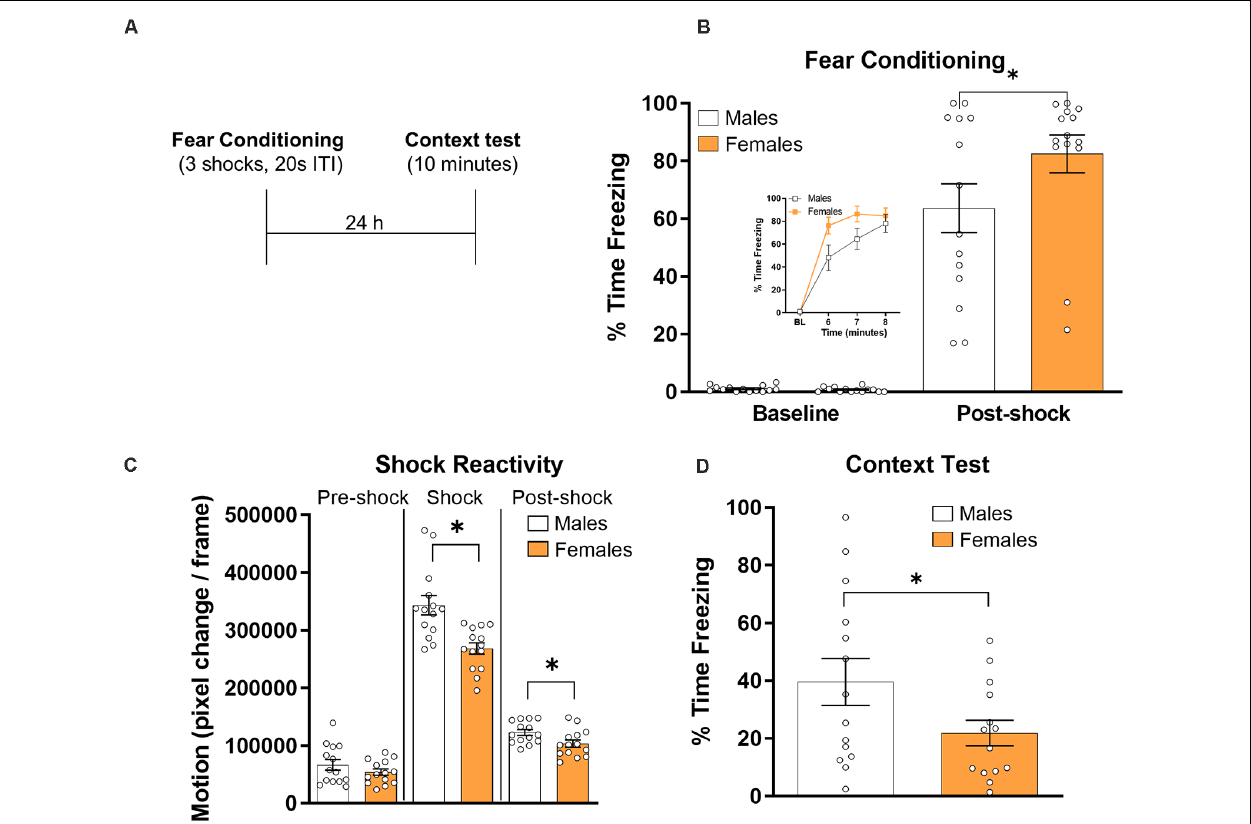
FIGURE 1 | Male ( N = 14) and female ( N = 14) were given contextual fear conditioning and freezing behavior was assessed during a 10 min test session the next day (panel A depicts the timeline of the experiment). (B) Freezing behavior during the baseline and post-shock periods during the fear conditioning session. The inset graph shows average baseline freezing and minute-by-minute freezing during the last 3 min of the conditioning session. (C) Shock reactivity and post shock activity burst as measured by the average number of pixel changes per frame for male and female rats during the 5 s before the shock (left panel), during the 1 s duration of the shock (middle panel), and during the 5 s after the shock (right panel). Freezing behavior during the context test session in male and female rats (D) . For all graphs, symbols reflect individual subject values and error bars reflect the standard error of the mean. ∗ p < 0.05.